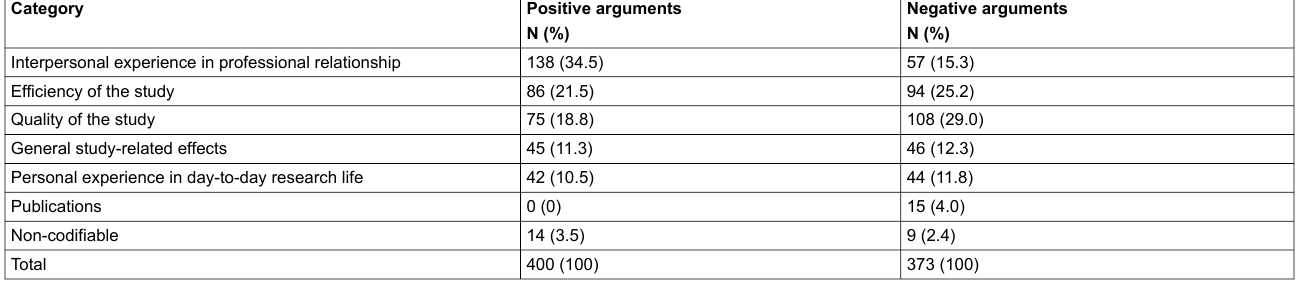
Table 3: Interest in an active involvement in the planning phase of a multi-centre study.